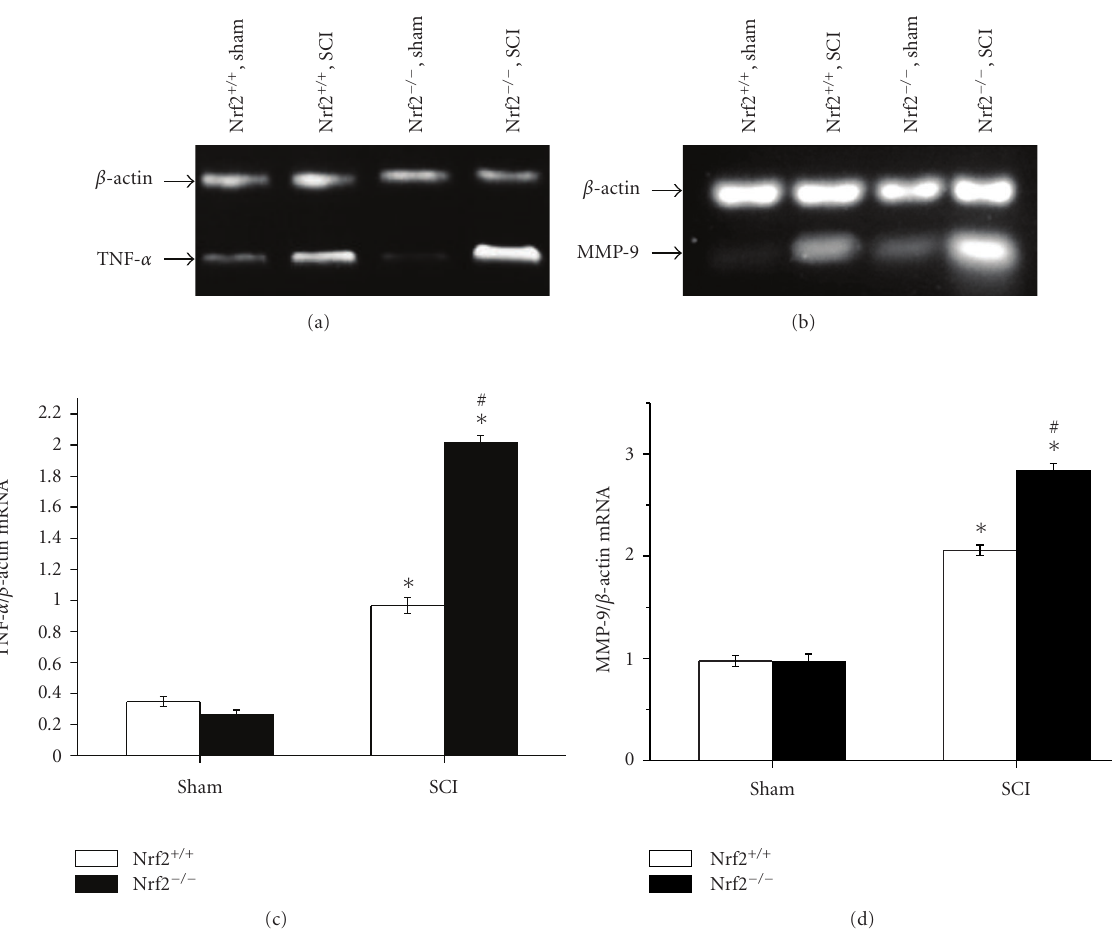
Figure 4: RT-PCR analysis for TNF- α and MMP-9 mRNA levels in the spinal cord samples of sham and injured Nrf2 (+/+) and Nrf2 ( − / − ) mice. (a) and (c) Representative agarose gel images show TNF- α and MMP-9 mRNA levels in sham and injured Nrf2 (+/+) and Nrf2 ( − / − ) mice, respectively. (b) and (d) the graphs show that higher mRNA expression levels of TNF- α and MMP-9 were found in Nrf2 ( − / − ) mice than in Nrf2 (+/+) mice at 24 hours after SCI, respectively. Bars represent mean ± S.E. ( n = 6, each group). ∗ P < . 01 versus genotype-matched sham-operated mice. # P < . 01 versus treatment-matched Nrf2 (+/+)